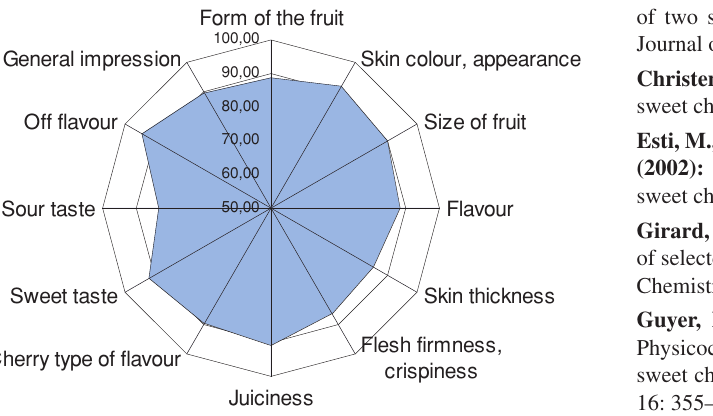
Figure 13. Profile diagram of the sensorial judgement of the variety Linda